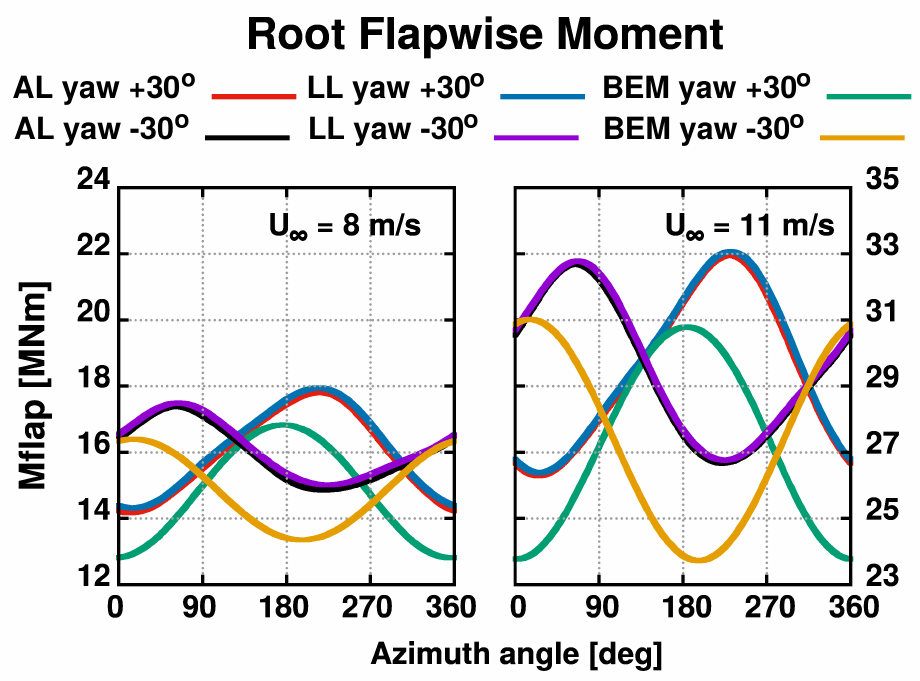
Figure 24. Out-of-plane bending moment of blade root at 30 ◦ yawed wind speed at 8 and 11